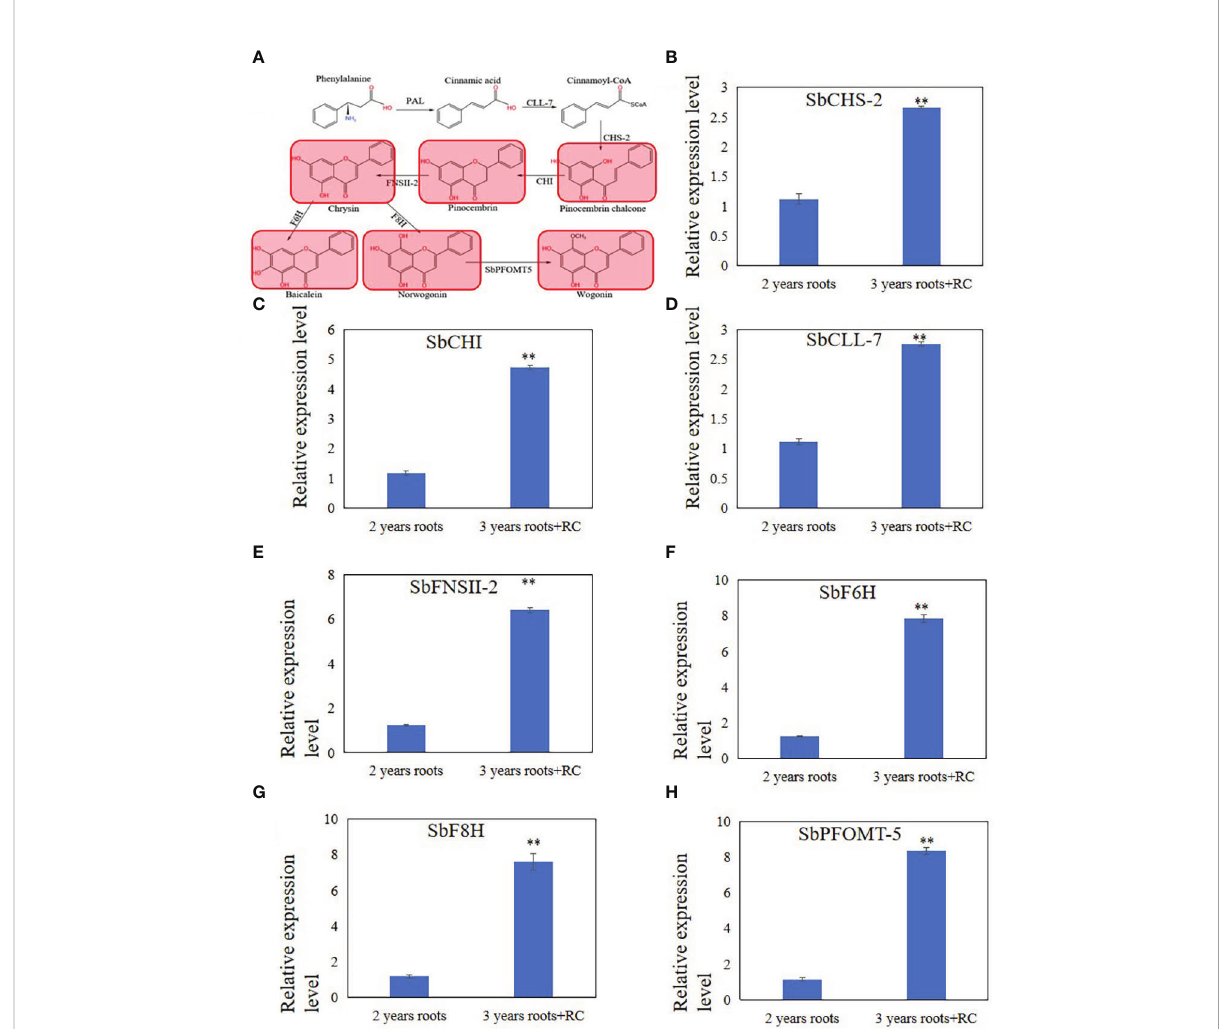
FIGURE 2 Differential expression metabolites and genes related to 4'deoxy fl avones biosynthesis discovered by metabolome and qRT-PCR analysis in 3 years roots with a hollow. (A) , Differential expression metabolites discovered by metabolome analysis. Read color indicate metabolites up-regulated in 3 years roots with a hollow. (B-H) , relative expression level of SbCHS-2 (B) , SbCHI (C) , SbCLL-7 (D) , SbFNSII-2 (E) , SbF6H (F) , SbF8H (G) and SbPFOMT-5 (H) . The relative expression level were calculated by Delta-delta Ct values. The data are the means ± SDs (n = 3), **means p <